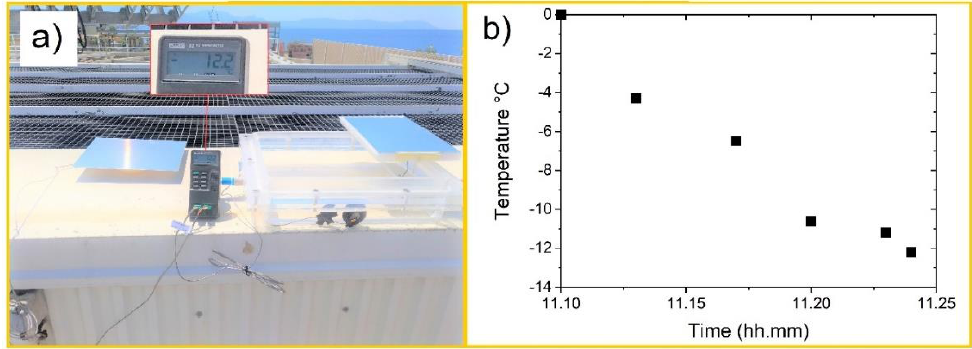
Figure 9. Comparative temperature test between CM and identical plate without coating exposed to clear sky conditions: (a) photo, (b) data. clear sky conditions: ( a ) photo, ( b )